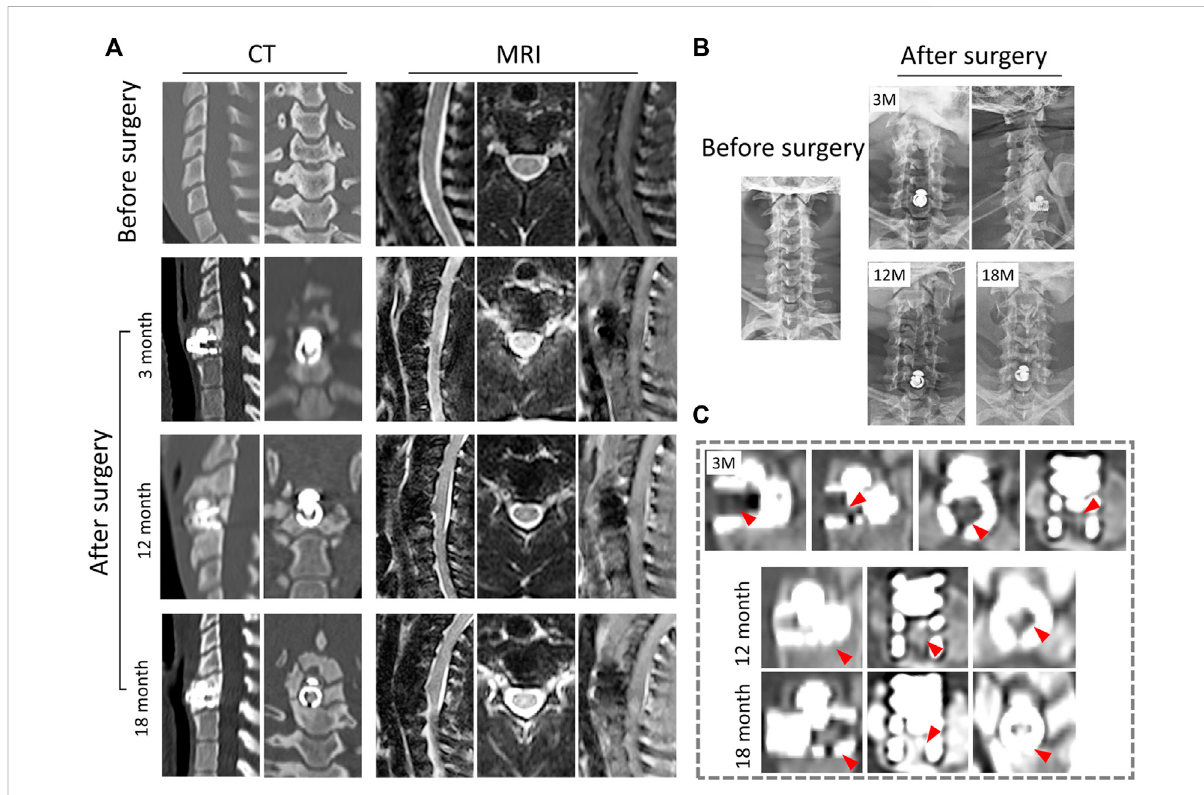
FIGURE 5 RadiologicalobservationofCSDPinnon-humanprimates. (A) CTandMRI1 monthbeforeand3,12,and18 monthsafterCSDPimplantation. (B) X-ray imaging 1 month before and 3, 12, and 18 months after CSDP implantation. (C) The trabecular bone gradually grew into the cervical vertebra fi xation (CVF) structure through the tunnel at 3 months post-operation. Increased quantity and density of trabecular bone grew into the